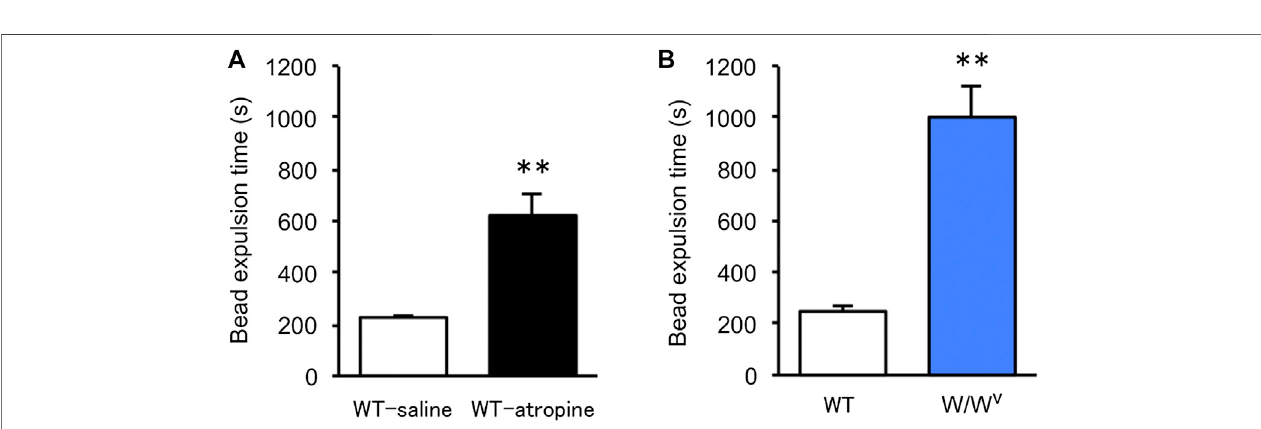
FIGURE 3 | Delayed colonic transit time in W / W v mice. Colonic transit was assessed by the bead expulsion time. (A) Bead expulsion time in the saline group (WT mice administered saline) and atropine group (WT mice administered atropine). Each column shows the mean ± SEM ( n (cid:2) 6 – 8). ** p < 0.01; signi fi cantly different from saline group. (B) Bead expulsion time in WT mice and W / W v mice. Each column shows the mean ± SEM ( n (cid:2) 7 – 8). ** p < 0.01; signi fi cantly different from WT